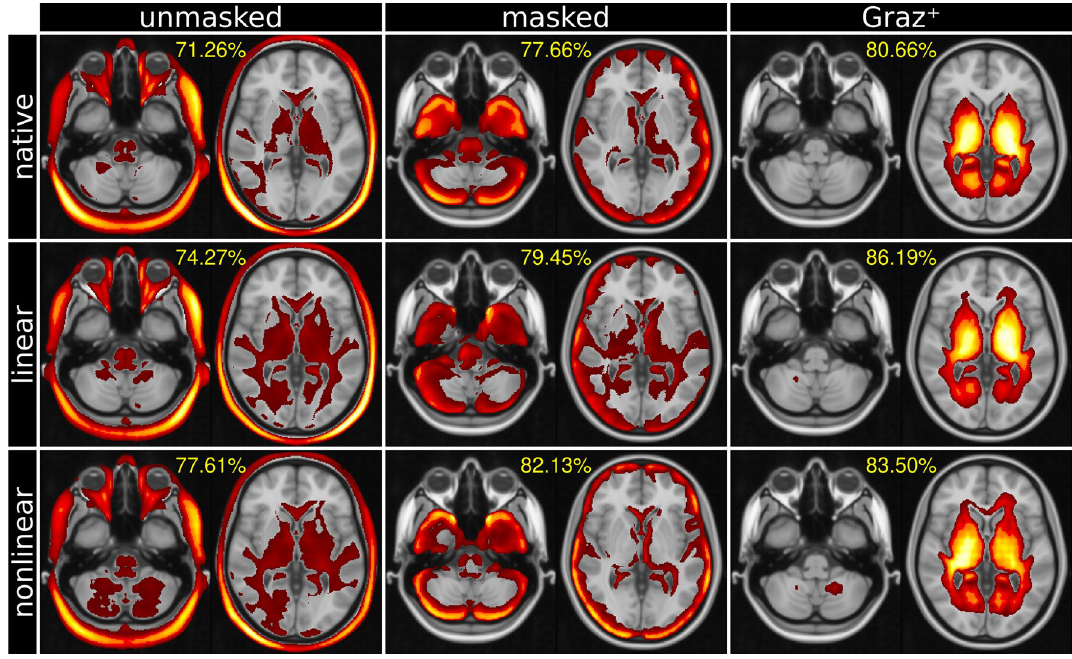
Figure 4. Mean heat maps (highest relevance in yellow, overlaid on MNI152 template) and balanced classification accuracy (percentage). Unmasked and masked CNN classifiers obtain relevant image